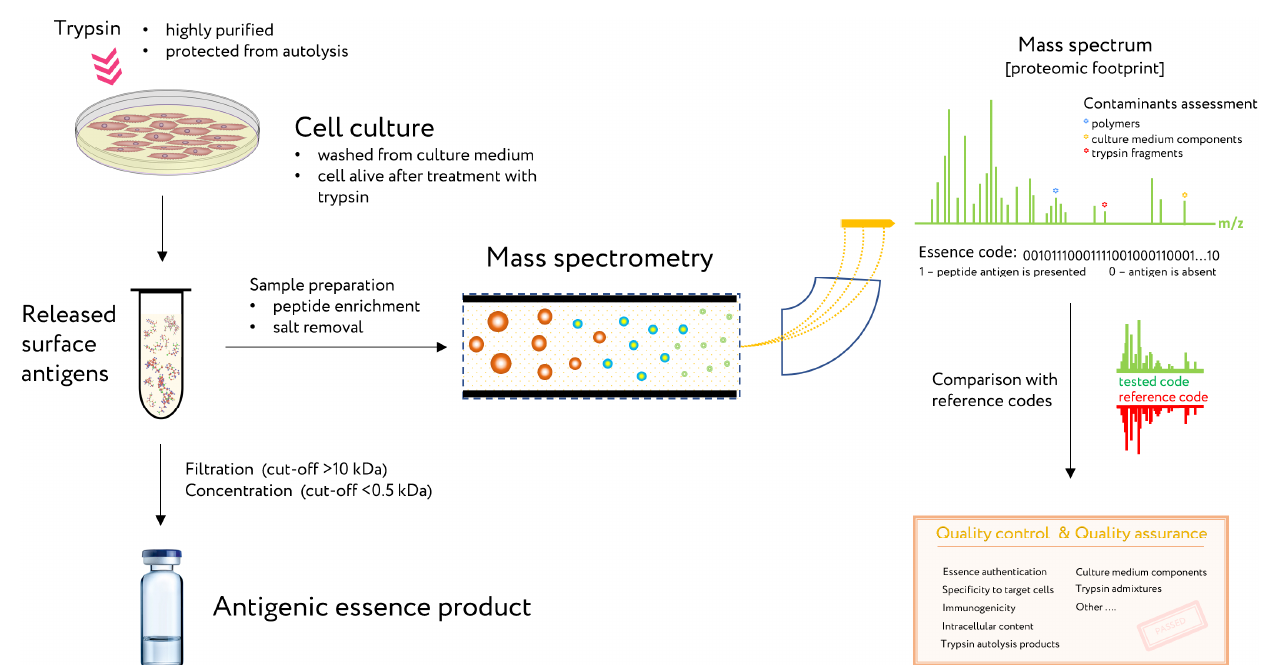
Figure 4. The use of proteomic footprinting in the antigenic essence production. After washing away traces of culture medium, adherent cell culture is treated with a protease. Released fragments of cell surface proteins are collected and analyzed by mass spectrometry. The set of obtained peptide molecular weights represents the essence code. Comparison of this code with mass spectra of the reference cells not only allows for authentication of the essence but also reveals any changes in its composition. This proteomic footprinting method was developed as a part of research and development for antigenic essence products and cell authentication at the subtype level. Adapted from [29].